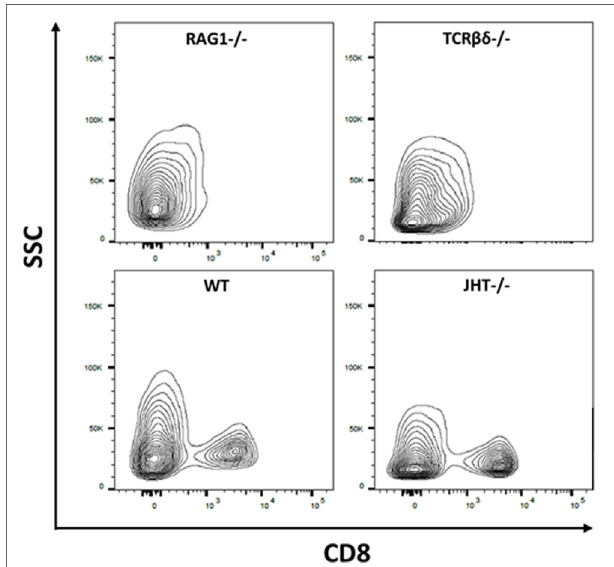
FigUre 12 | cellular composition of wild-type (WT), recombination activating gene 1 homozygous knockout (rag1 − / − ), T cell receptor β and δ chain homozygous knockout (Tcr βδ − / − ), and joining region homozygous knockout (JhT − / − ) mice . Flow cytometry was used to determine whether CD8 + T cells are present in the mouse strains used in this analysis. CD8 + T cells have been shown to impact bone healing (7). While RAG1 − / − and TCR βδ − / − lacked CD8 + T cells these cells were present in WT and JHT − / − animals. Gating: lymphocytes, single cells, live cells, CD45- positive cells, CD3-positive cells, and CD8-positive